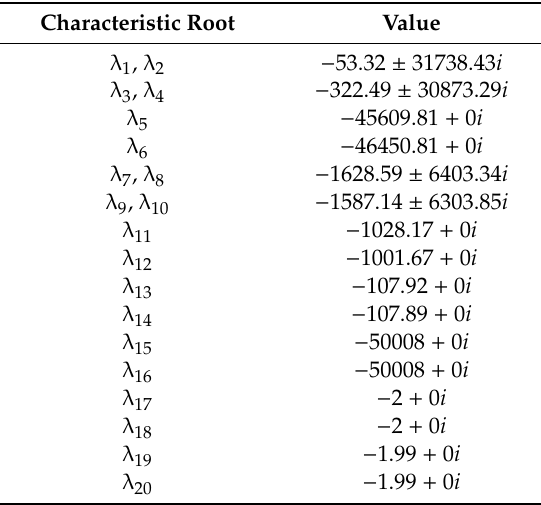
Table 1. The eigenvalues of